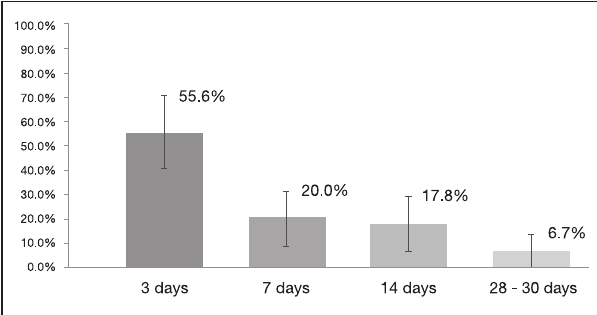
Figure 3) Rebleeding rates at different time points in patients receiving high- dose proton pump inhibitors (95% CIs represented by vertical lines)